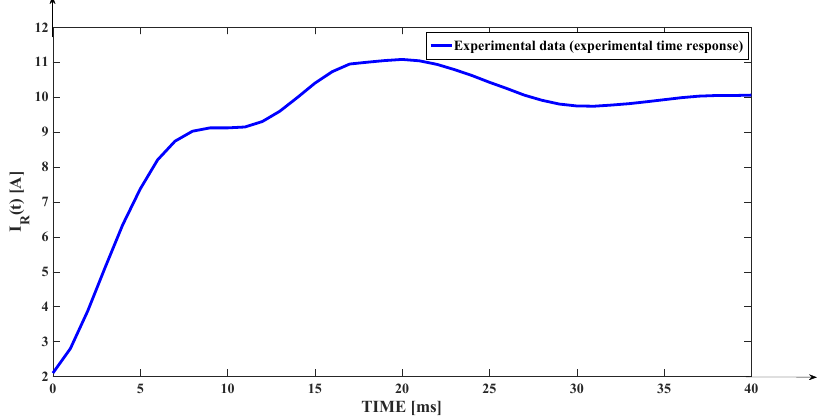
Figure 16. Dynamics of the I R (t) signal (experimentally obtained).